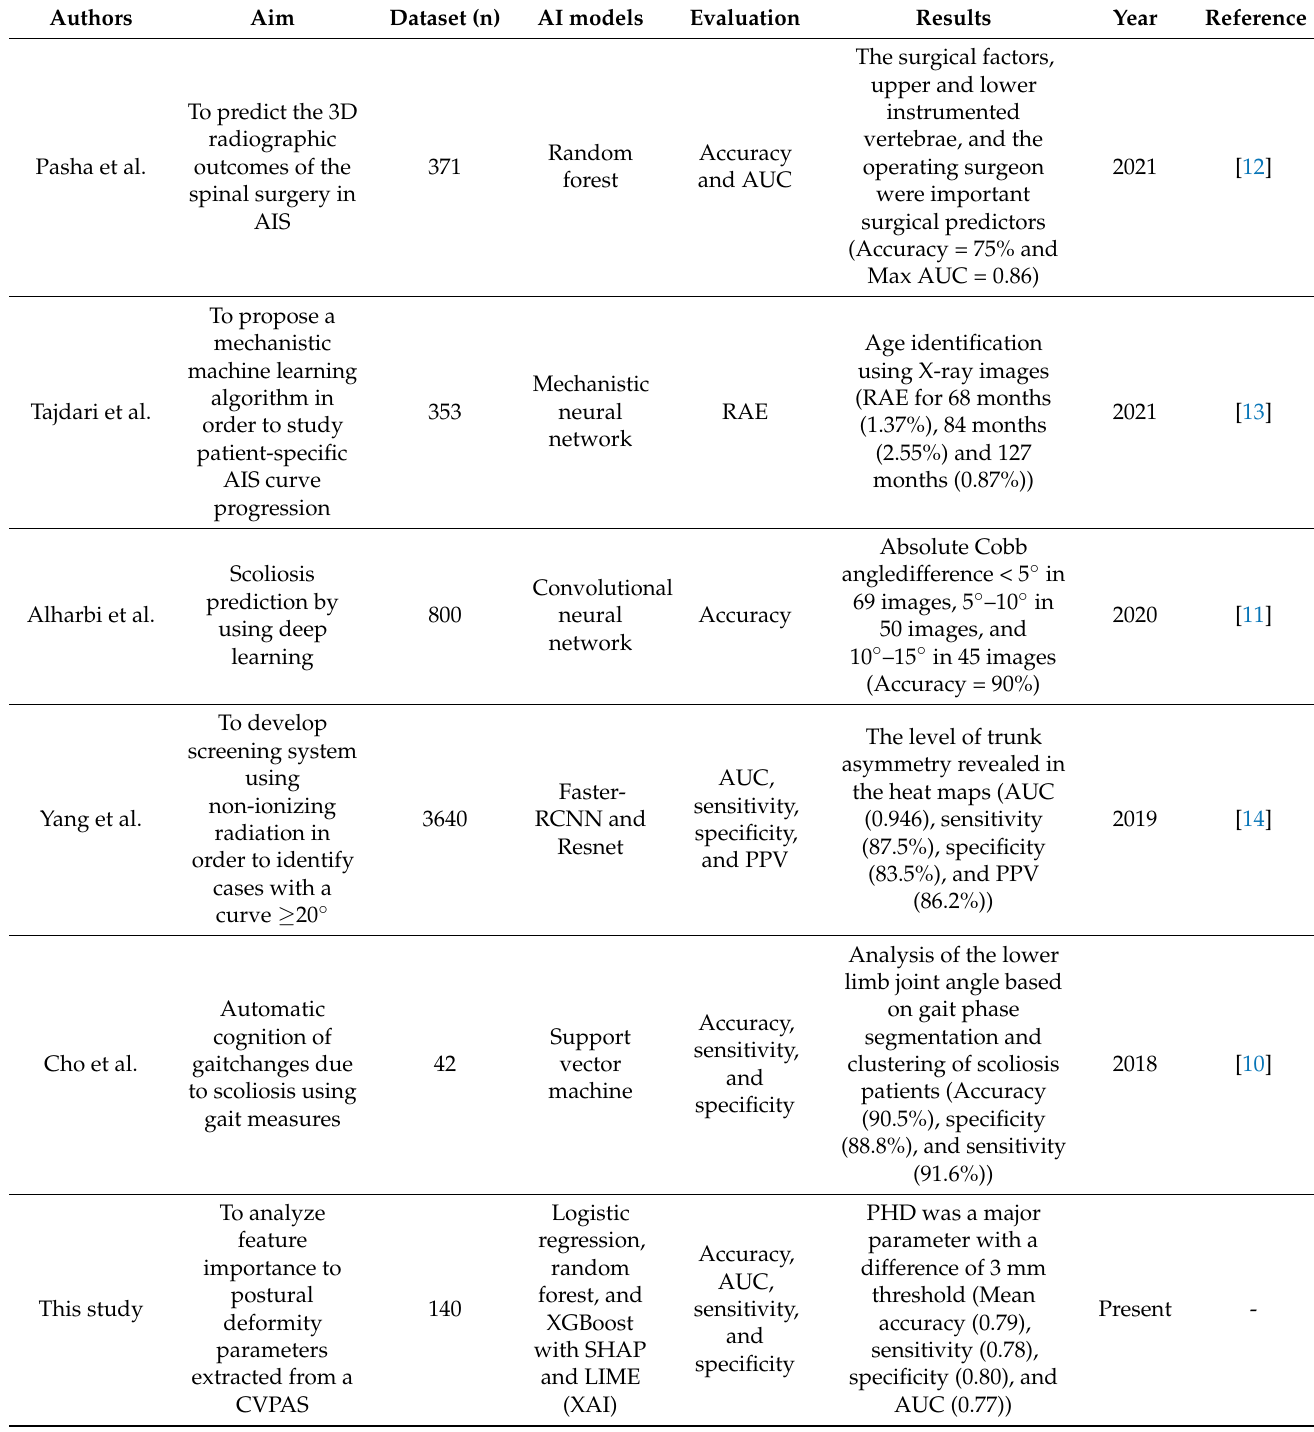
Table 5. AI studies for scoliosis or postural deformity